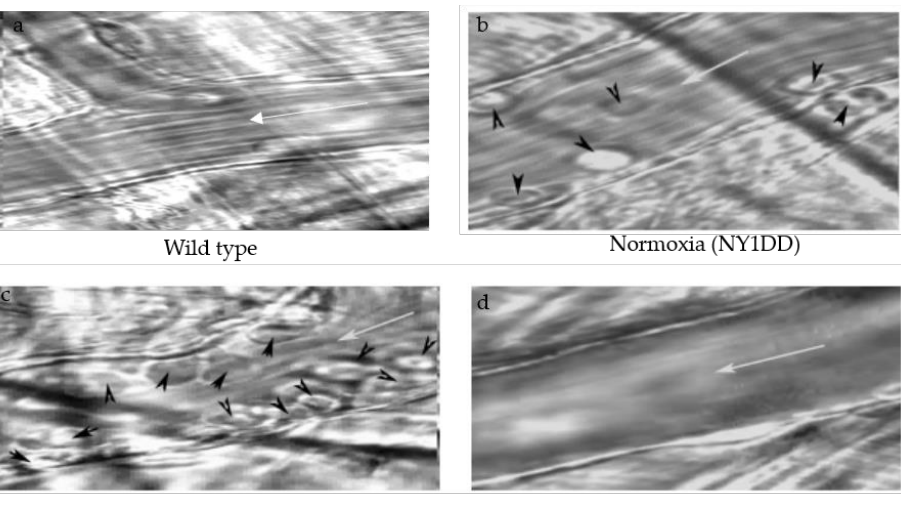
Figure 2. Intravital microscopy of cremaster venules of transgenic sickle cell mice (NY1DD) showing ameliorating effects of single dose quercetin (200 mg/kg, i.p.) on leukocyte adhesions and extravasation. ( a ) Wild type control mice; ( b ) normoxic NY1DD mouse shows few rolling leukocytes and adhesion; ( c ) after 18 h of hypoxia and 3 h of reoxygenation, cremaster venules show marked leukocyte adhesion, as well as emigrated leukocytes (arrows head); ( d ) administration of quercetin at the onset of reoxygenation in NY1DD mice almost completely abolished leukocyte adhesion and emigration. White arrow ( → ) indicates the blood flow direction and black arrowhead indicates leukocytes.